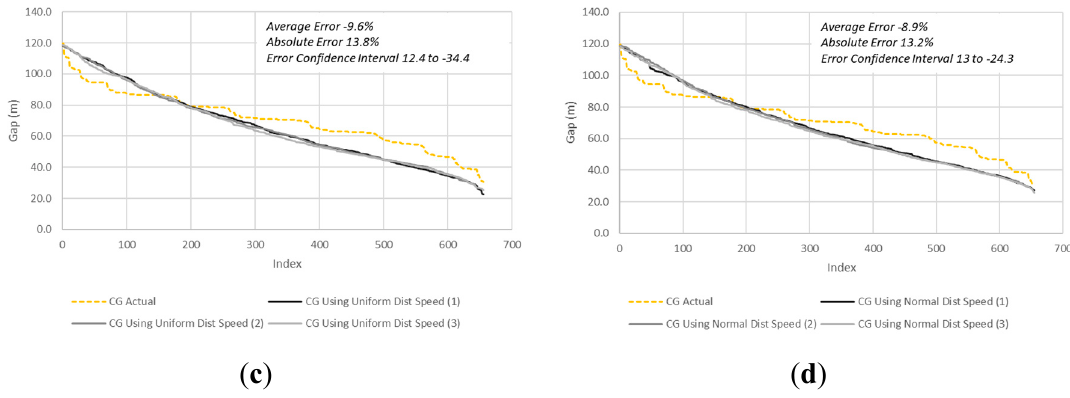
Figure 3. Comparison between actual data and simulation results for different speed distributions. ( a ) Average speed; ( b ) incremental speed; ( c ) uniform distribution speed; ( d ) normal distribution speed. To enhance the fit, the speed in the normal distribution runs was multiplied by a positive factor.